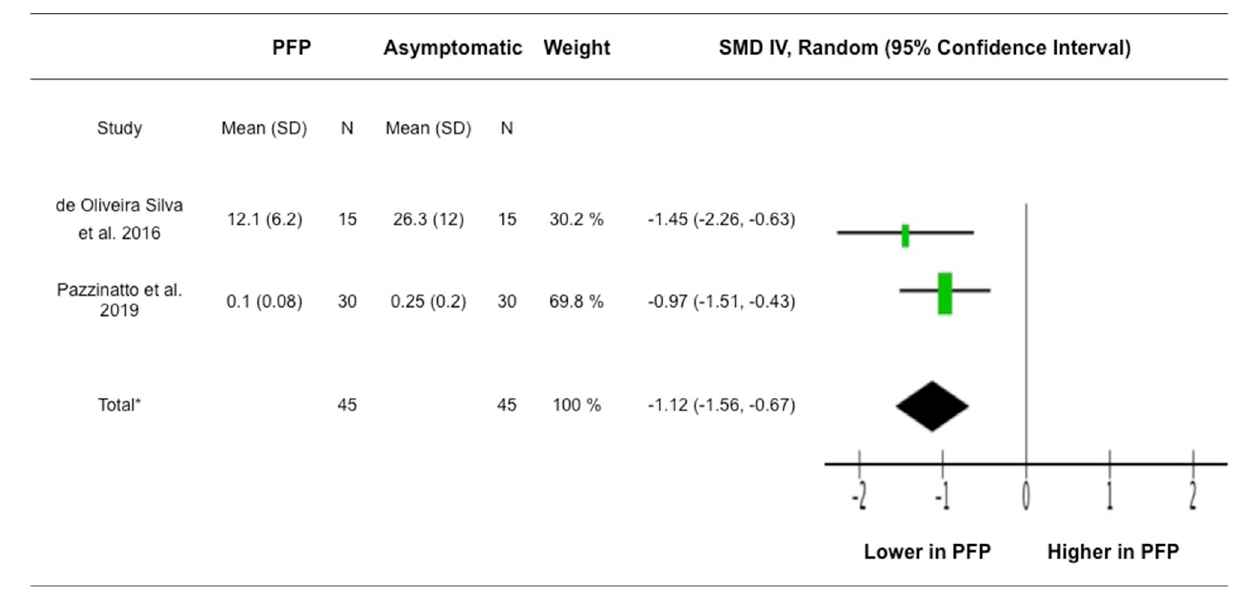
FIGURE 3 | Meta-analysis for VM H-reflex amplitude. *Heterogeneity: Tau 2 = 0.00, Chi 2 = 0.91, df = 1 ( P = 0.34), I 2 = 0%. Test for overall effect: Z = 4.87 ( P < 0.00001). IV, inverse variance; SMD, standardized mean